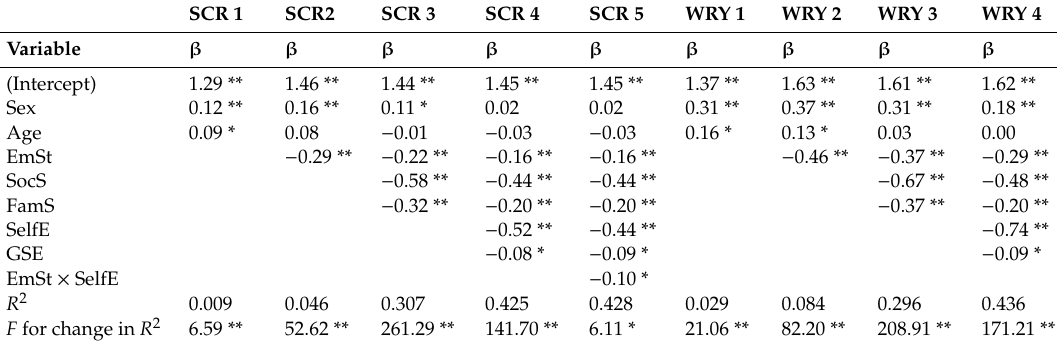
Table 3. Summary of nested regression analysis for variables predicting chronic stress (SCR) and of regression analysis for variables predicting chronic worrying (WRY) ( N =